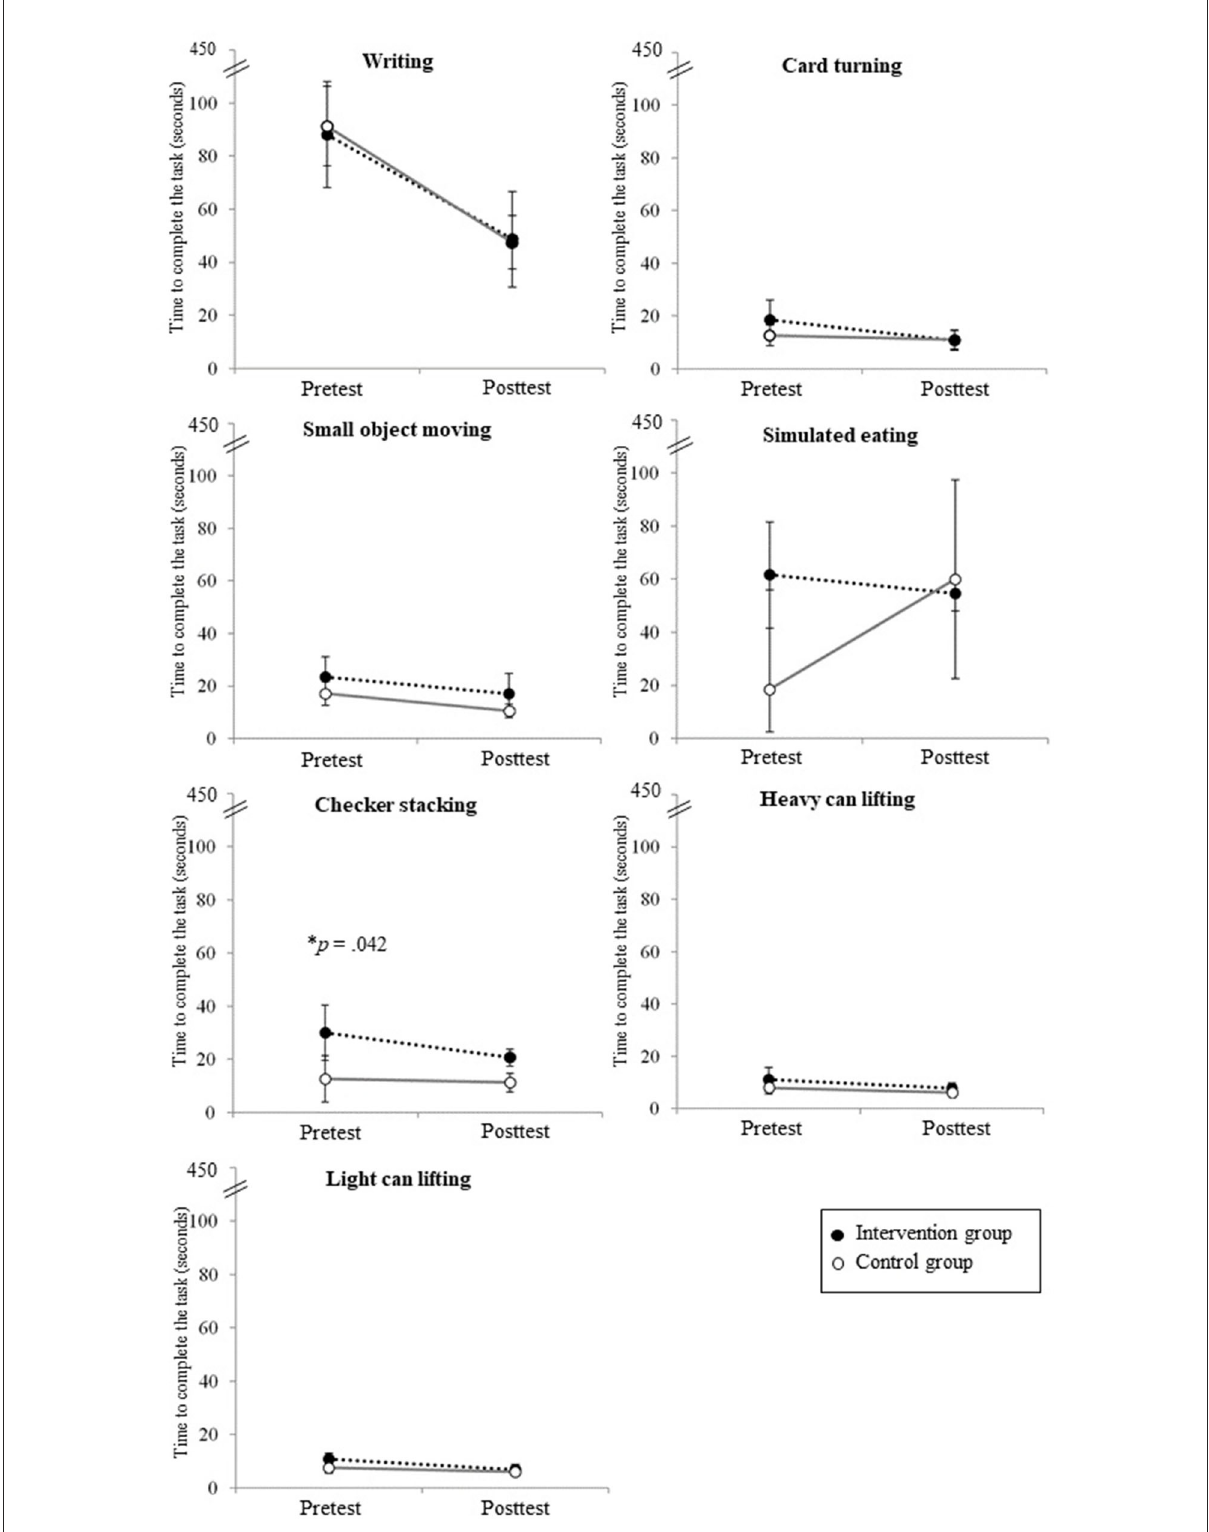
FIGURE3 The changes in seven subtests of the JTHFT in each group. The interaction effect between group and time was significant only in the checker-stacking